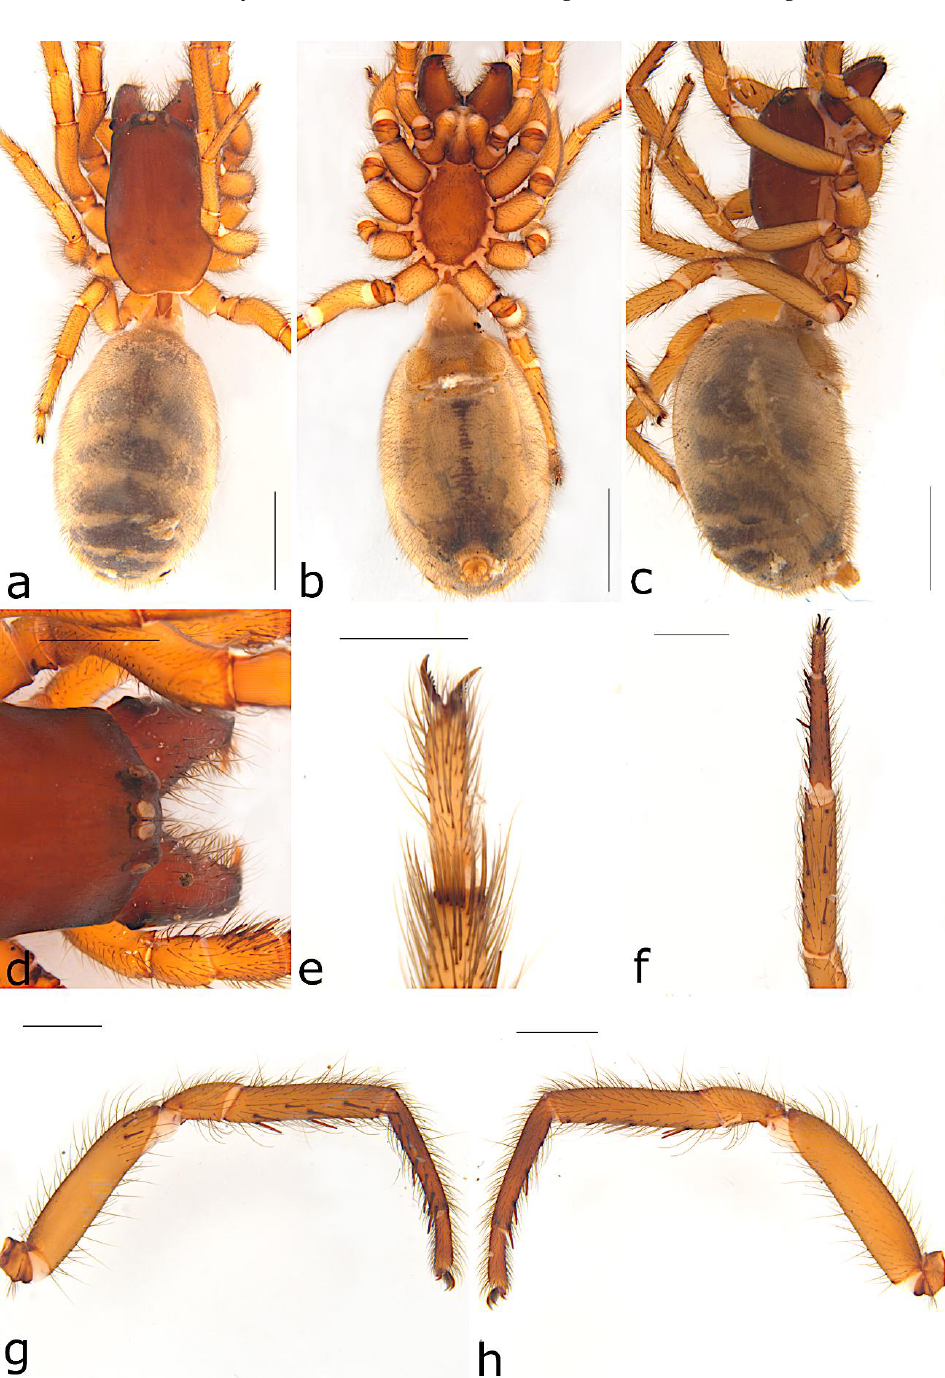
Figure 15. Ariadna sinuosa sp. nov. ♀ paratype (MV K-4990) from Archeron Gap (Vic): ( a ) habitus, dorsal view; ( b ) same, ventral view; ( c ) same, lateral view; ( d ) eyes, dorsal view; ( e ) left metatarsus IV, preening comb, retrolateral view; ( f ) left leg I, ventral view; ( g ) same, prolateral view; ( h ) same, retrolateral view. Scale bars ( a – c ) = 2mm, ( d ) = 1 mm, ( e ) = 0.5 mm and ( f – h ) = 1 mm.